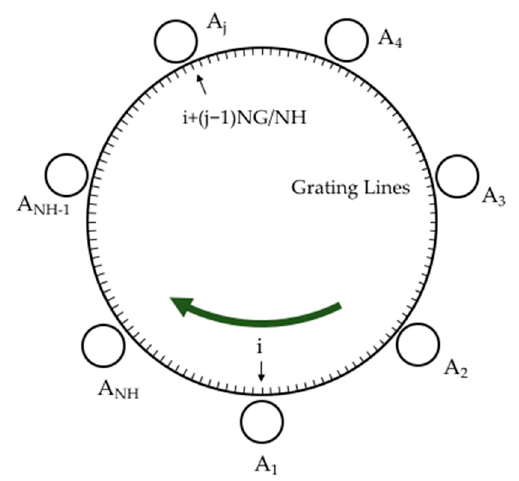
Figure 3. Relationship between the sensor heads and the grating lines of the rotary encoder [10].